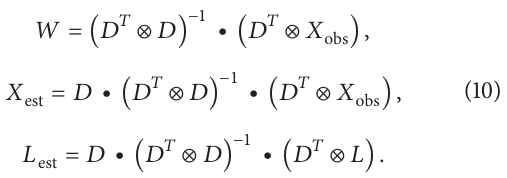
Figure 6: Update of training data 𝑇 with quantitative update